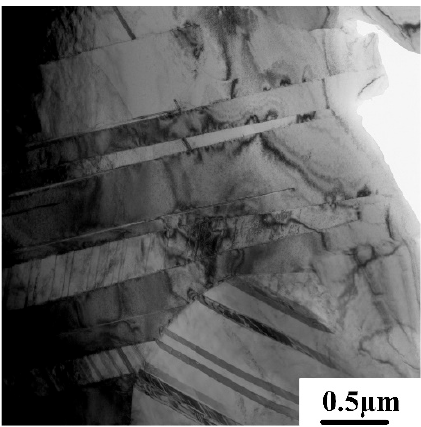
Figure 8. Mechanical twinning in a Ti–43Al–2Cr–2Mn–0.2Y alloy with FL microstructure observed after tensile deformation at 750 °C.